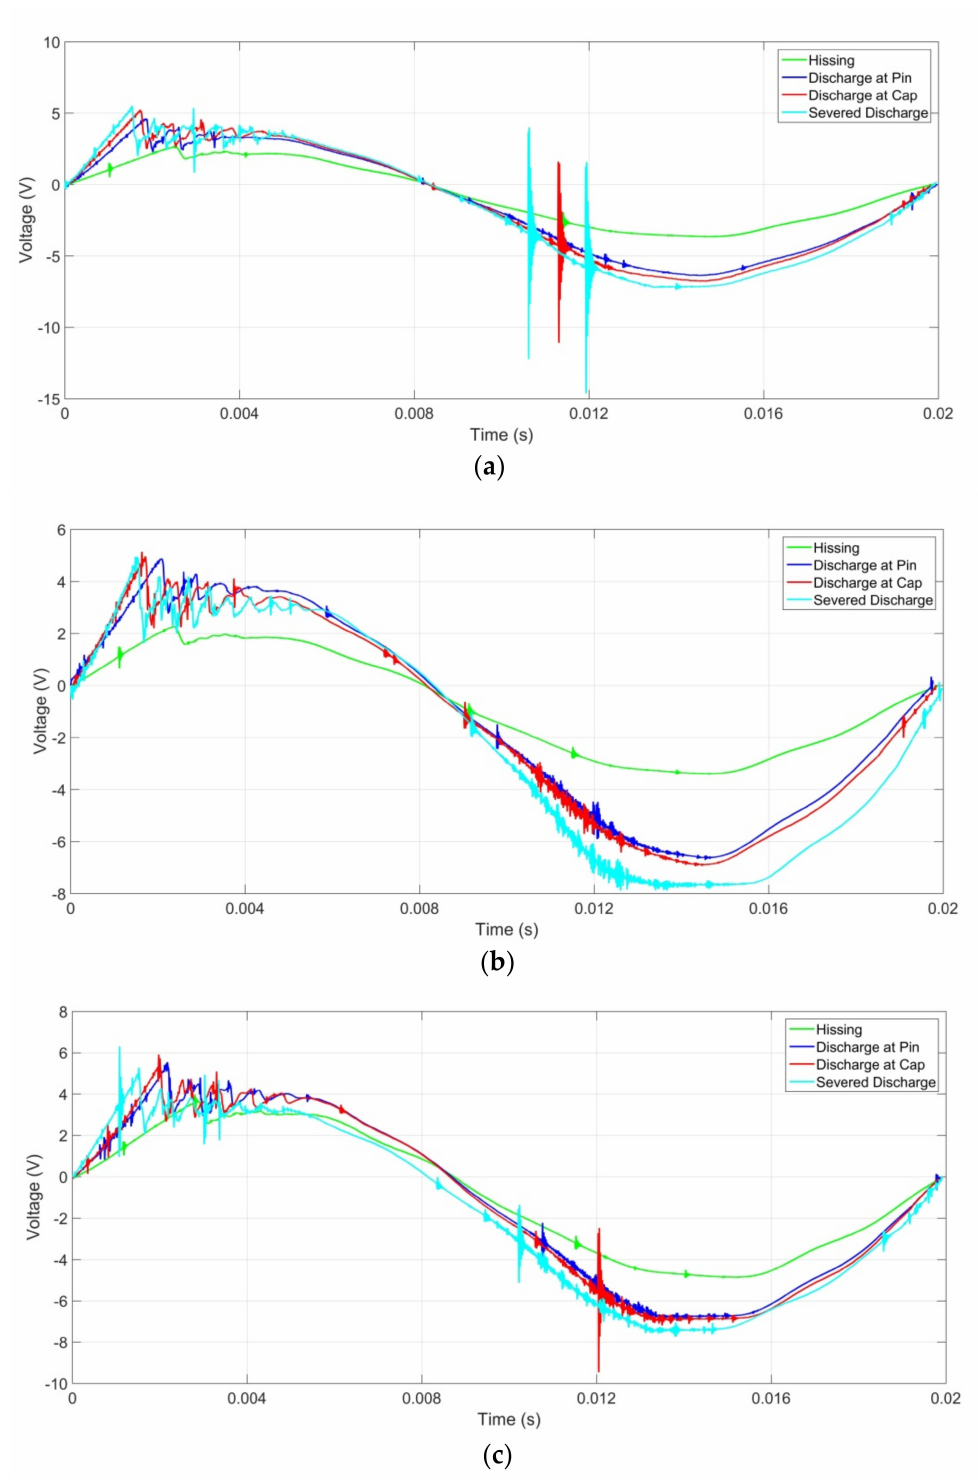
Figure 7. UV signal for insulator samples at medium contamination level with insulator ages